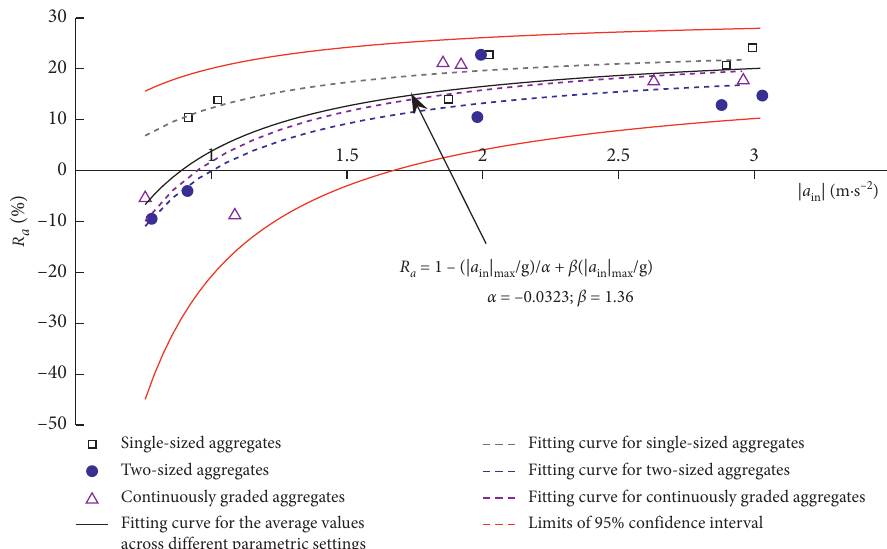
Figure 11: Relationships between the vibration reduction rate of the gravel cushion and the peak input acceleration. Table 4: Fitted parameters of the average vibration reduction rate of gravel cushions at different parameter settings. Parameter Fitted value Lower limit of 95% confidence interval Note. Regression coefficient of correlation is 0.8182. Table 5: Regression parameters for the vibration reduction rates of the three gravel cushions. Cushion